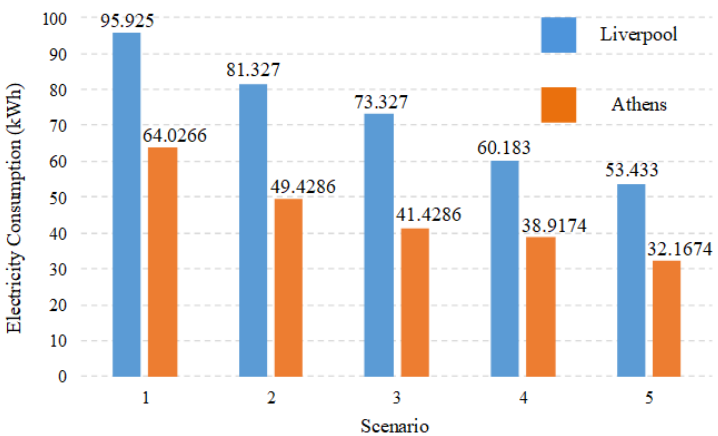
Figure 5. Electricity consumption of the Biochrom 30+ amino acid analyzer physiological system with the HVAC system power ratings for Liverpool and Athens in October.